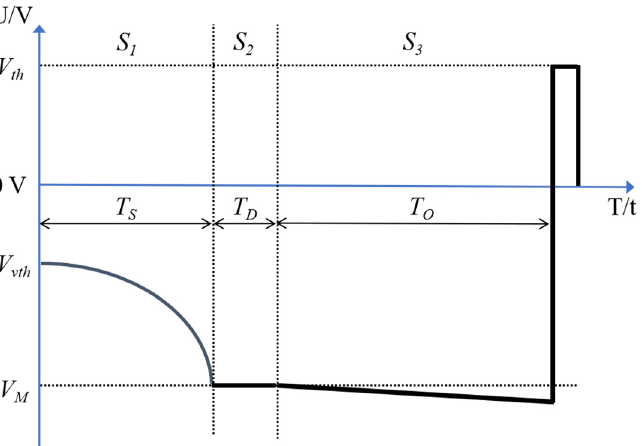
Figure 6. A schematic diagram of one cycle of the proposed driving waveform. It was optimized based on the threshold voltage of EWD.